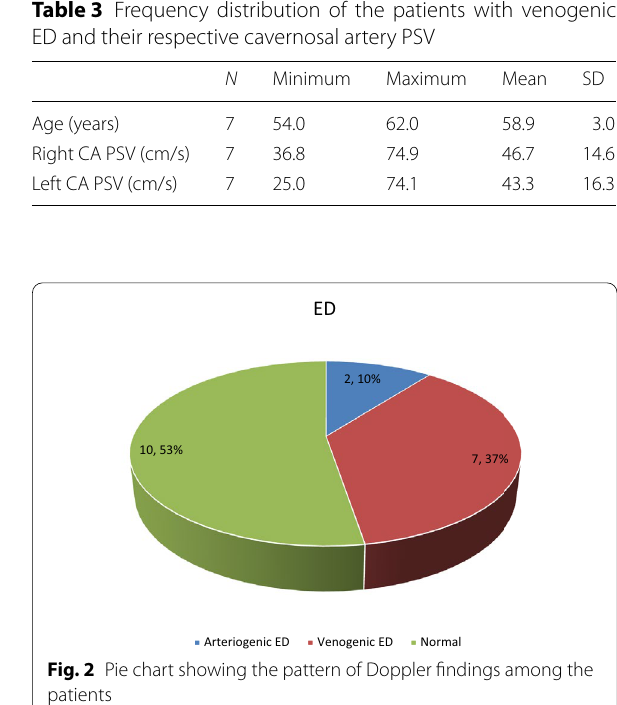
Table 1 Frequency distribution of the entire patients with their